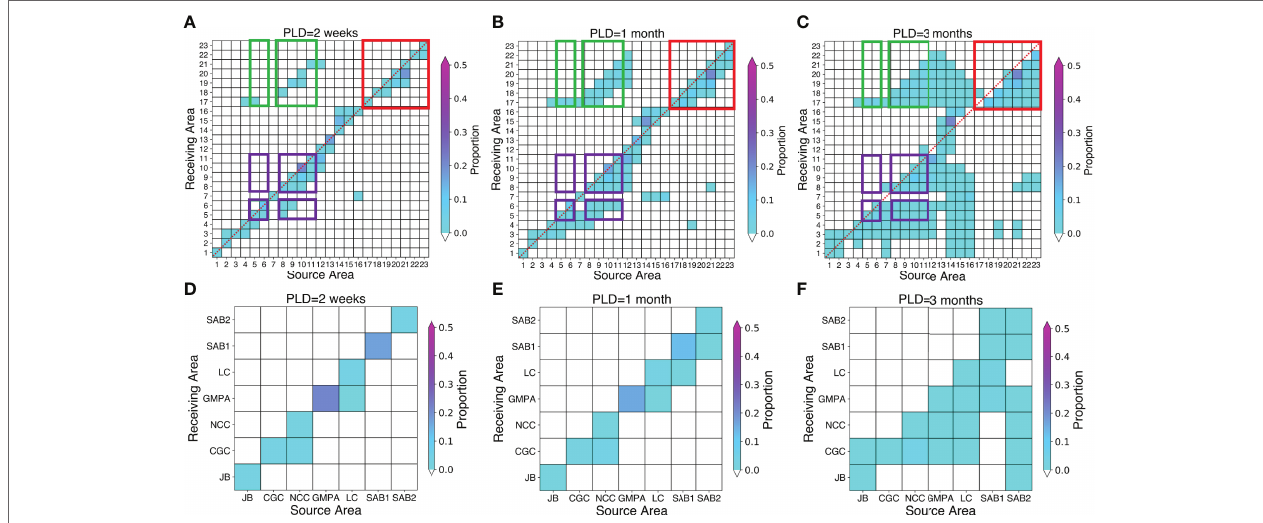
FIGURE 9 | (A–C) Proportions of virtual particles released from each source box, in ensembles of seasonal LPT simulations using long-term averaged currents, that pass over or terminate in each source box (termed: “Receiving Area”), during 2-week (left column), 1-month (centre column) and 3-months (right column) PLDs. Shading on the major diagonal indicates particle retention in the source box at the end of the PLD. Red outlines indicate deep-slope source boxes; purple outlines indicate upper-slope source boxes; green outlines indicate connectivity from upper-slope to deep-slope source boxes. (D–F) Extracts from the above matrices, showing connectivity among source boxes in conservation areas: 1, Jordan Basin Conservation Area, JB; 3, Corsair and Georges Canyons Conservation Area, CGC; 4, Northeast Channel Coral Conservation Area, NCC; 10, Gully MPA, GMPA; 11, Lophelia Coral Conservation Area, LC; 13, 14, St. Anns Bank MPA, SAB1,